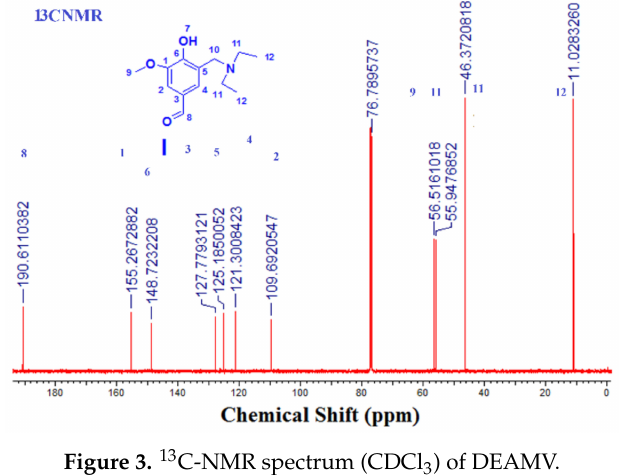
Figure 3. 13 C-NMR spectrum (CDCl 3 ) of DEAMV.